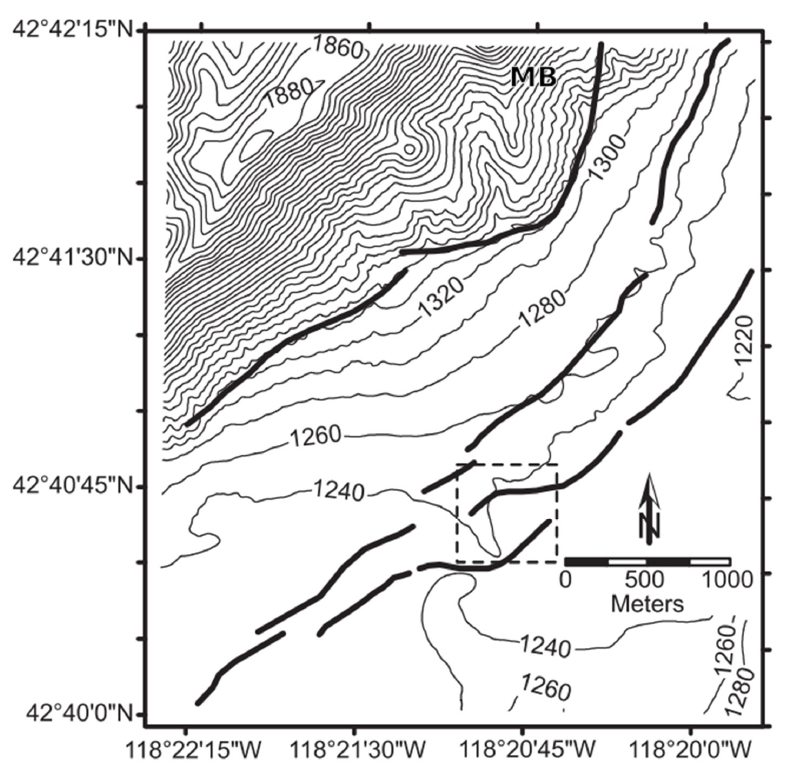
Figure 3. Topographic map and inferred locations of faults of Mickey Springs area as mapped by J.S. Oldow (unpublished data from 2006, fide [15]). Dashed box is the study area of Anderson and Fairley [15], and the approximate extent of the current study.